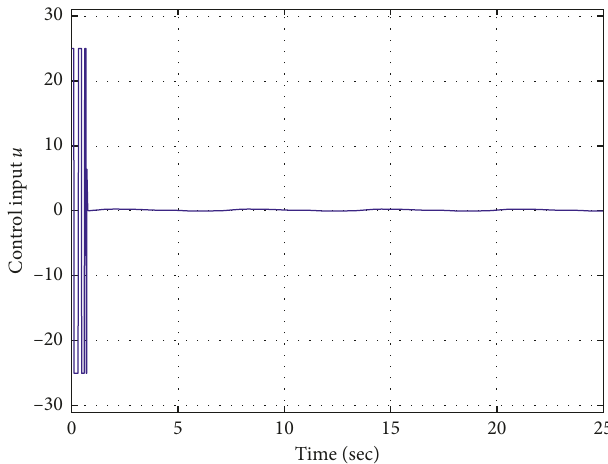
Figure 6: Evolution of the control input.